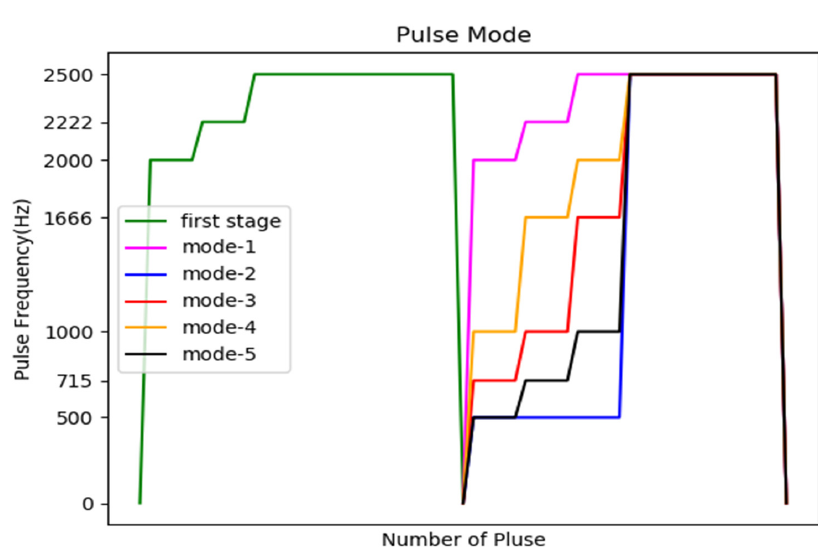
Figure 24. Time distribution diagram of pulse frequency in the first control mechanism.